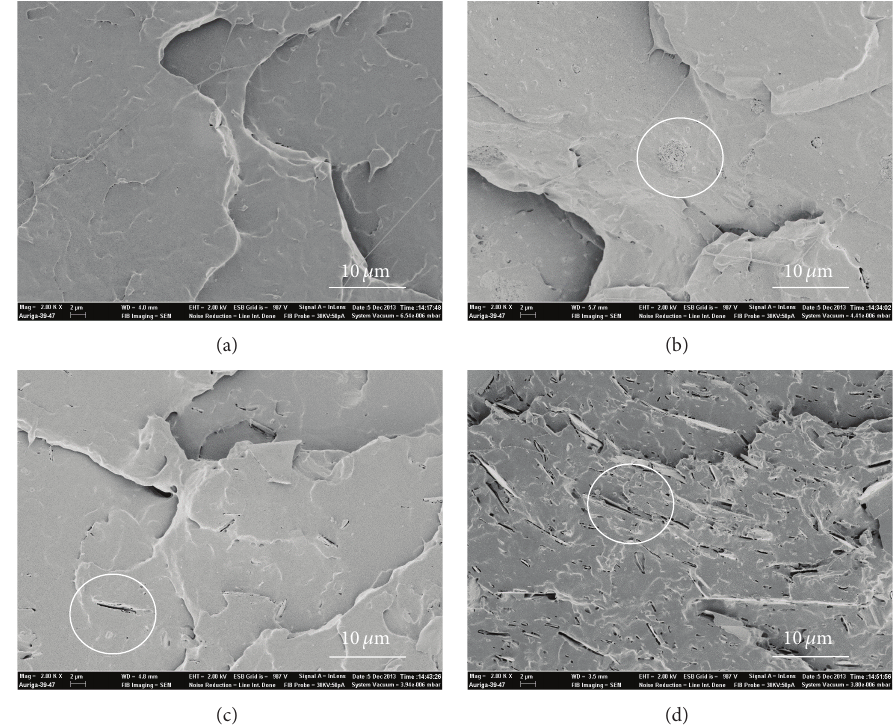
Figure 3: SEM images of PLA based composites: (a) PLA4032; (b) PLA-c/HA; (c) PLA-c/Talc 2; (d) PLA-c/Talc 5.